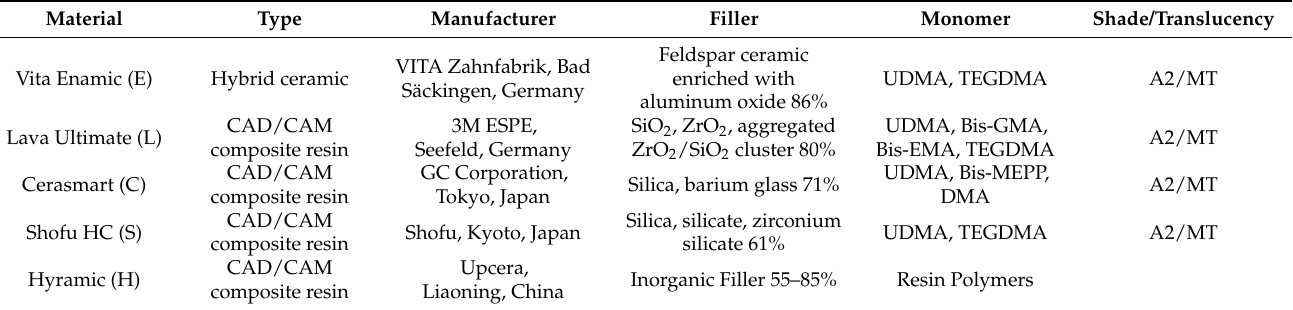
Table 1. Composition and manufacturer specifications of tested materials